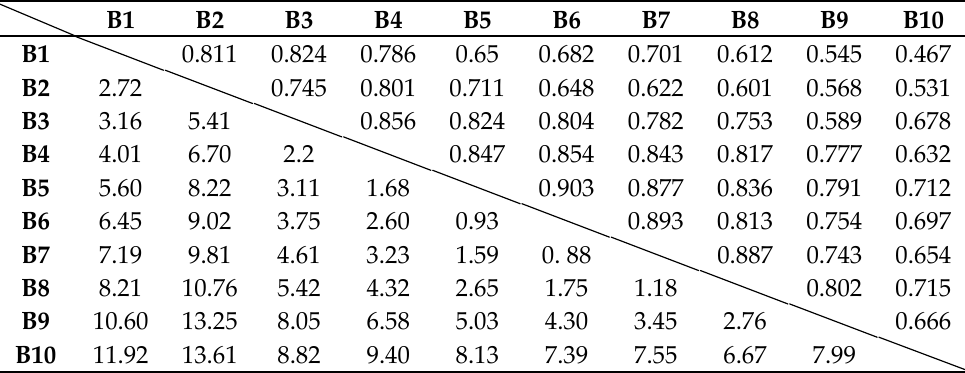
Table 4. Relationship between wind turbine correlation coefficients and turbine (short distance). B1–B10 are the IDs of the turbine sample.